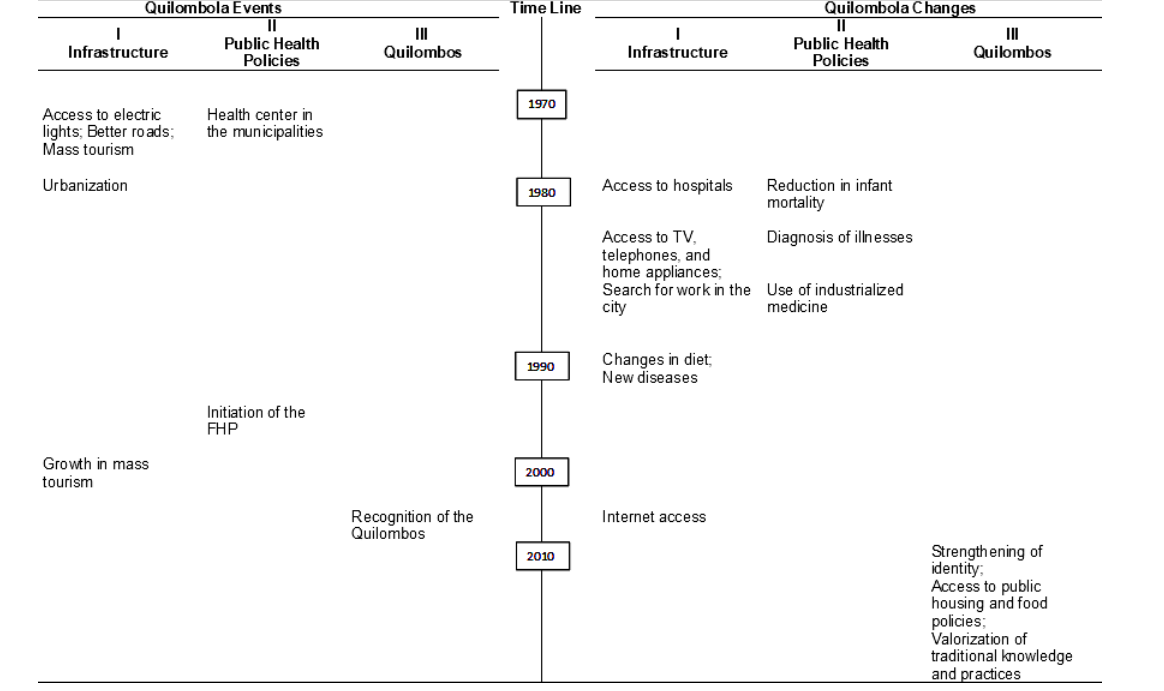
Fig. 4 . Events affecting traditional healthcare systems (THS) and resulting changes in Quilombola communities, southern coastal Brazil. FHP = Family Health